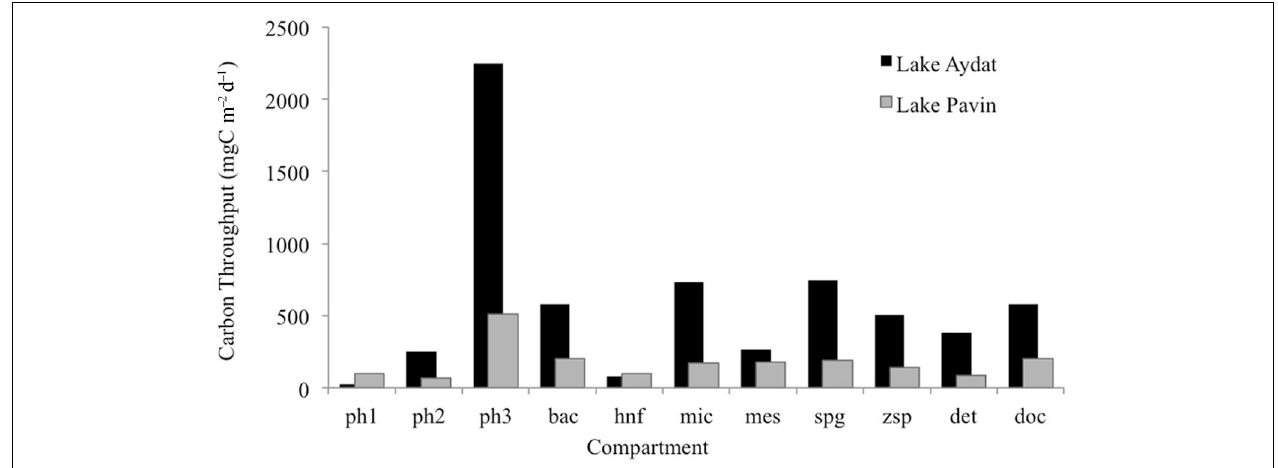
nanophytoplankton; Ph3, microphytoplankton; Hnf, heterotrophic nanoflagellate; Mic, microzooplankton; Mes, mesozooplankton; Spg, sporangia; Zsp, zoospores; Det, detritus; Doc, dissolved organic